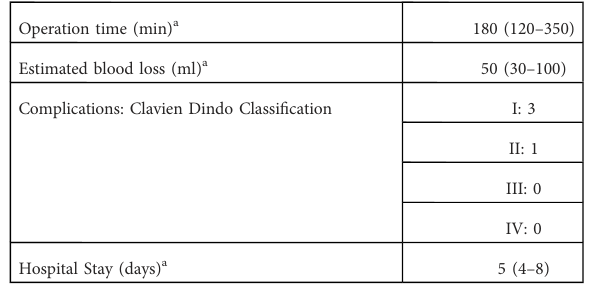
TABLE 4 Perioperative clinical results.